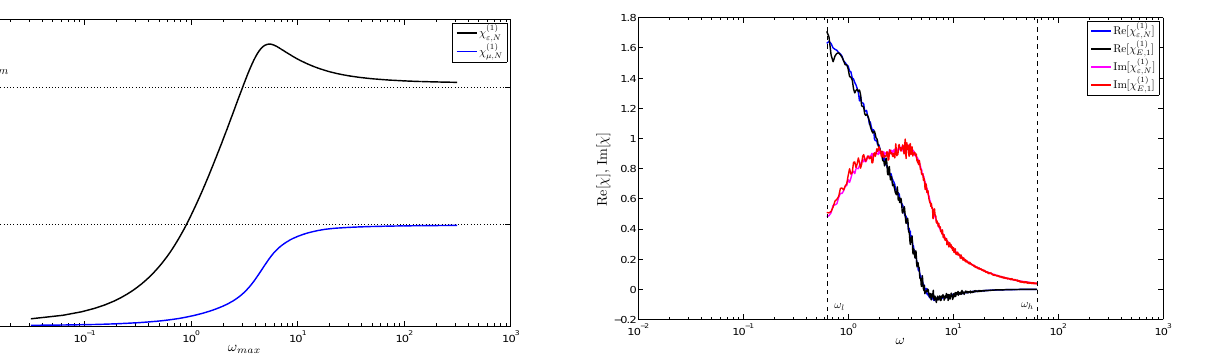
Fig. 3. Sum Rules for the real part of the linear susceptibility of Figure 3: Sum Rules for the real part of the linear susceptibility of intensive energy E/N intensive energy E/N (black line) and momentum M/N (blue line) (black line) and momentum M/N (blue line) of the system with respect to the global per- of the system with respect to the global perturbation with X i = 1 ∀ i . turbation with X i = 1 ∀ i . The theoretical values are indicated in the figure. The theoretical values are indicated in the figure.